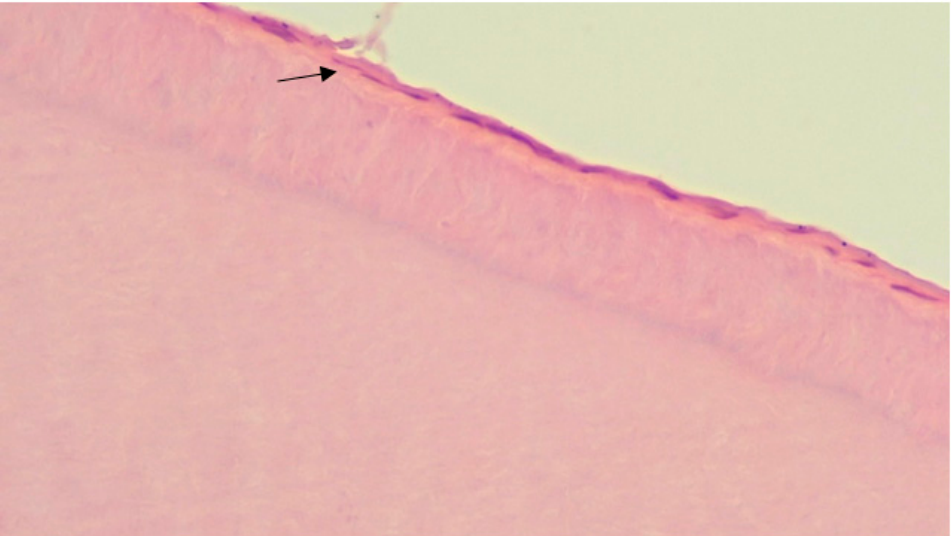
Figure 5. Superficial enamel lesion in the control group (during microscopic examination of enamel, changes develop only in the surface layers of enamel in the form of displacement of enamel prisms relative to each other. Staining with Ehrlich’s hematoxylin, in magnification ×